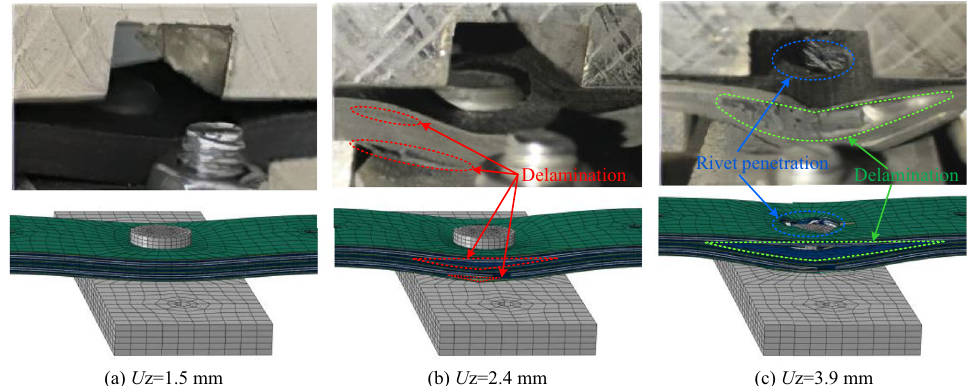
Figure 10 Comparison of damage propagation of the specimens between experiment and finite element model when displacement U z is equal to: a 1.5 mm; b 2.4 mm; c 3.9